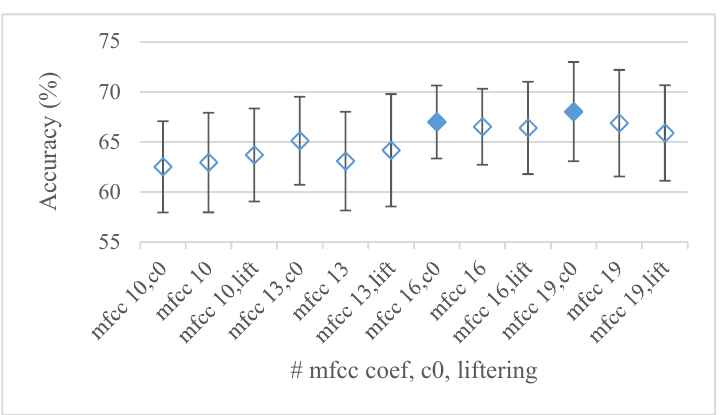
Figure 20. Averaged accuracies and standard deviations for the following MFCC settings: number of coefficients: 10, 13, 16, and 19, with and without c0, and liftering, for an 8 kHz maximal frequency and 60 FBs. Filled marks show equally performing settings.